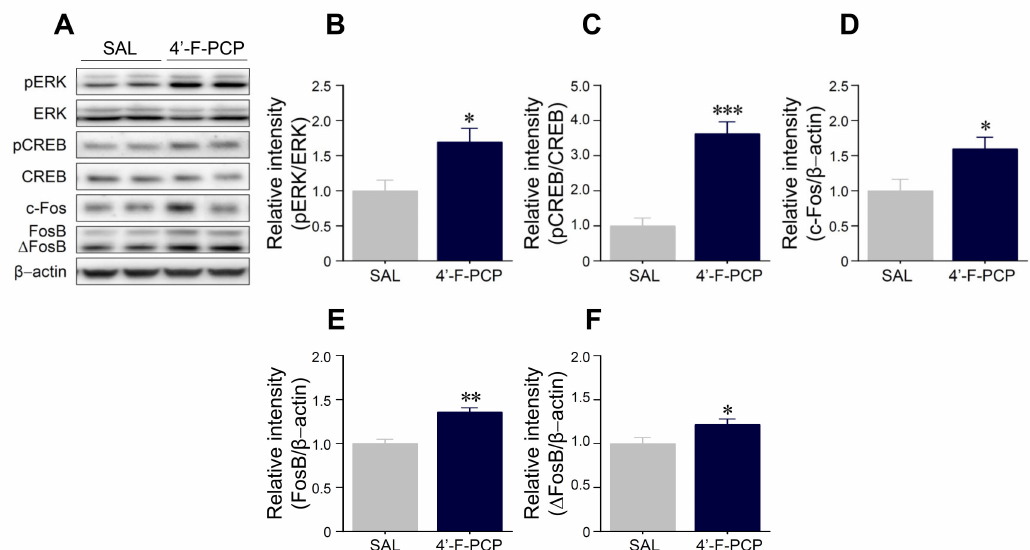
Figure 6. E ff ect of 4 (cid:48) -F-PCP on the immunoreactivities of pERK, pCREB, c-Fos, and FosB / ∆ FosB proteins in the NAc of 4 (cid:48) -F-PCP-self-administered rats under the PR schedule. ( A – F ) Immunoreactivities of pERK, pCREB, c-Fos, and FosB / ∆ FosB proteins in the NAc after saline or 1.0 mg / kg / infusion 4 (cid:48) -F-PCP self-administration under the PR schedules of reinforcement. Asterisks *, **, and *** indicate p < 0.05, p < 0.01, and p < 0.001, respectively, vs. saline controls. SAL: saline. n = 4–6 per